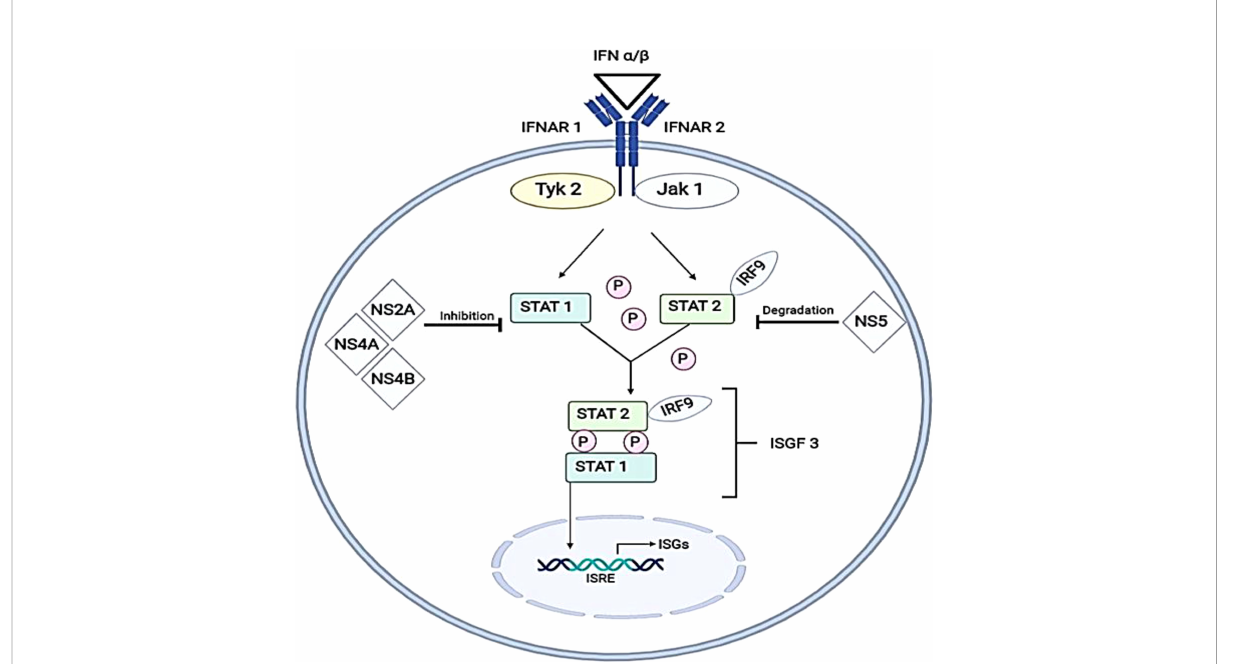
FIGURE 2 Inhibition of IFN a / b (type I IFN) signaling pathways by DENV virus. The pathway of formation for IFN-stimulated gene complex 3 (ISGF3) before translocating into the nucleus to induce IFN-stimulated genes by binding with IFN-stimulated response element (ISRE) is illustrated. DENV antagonizes this pathway by either inhibiting the active phosphorylation of STAT1 (by NS2A, NS4A and NS4B) or by direct degradation of STAT2 (by NS5). This illustrates mechanisms will occur in the absence of enhancing antibodies. IFNAR1, Interferon alpha and beta receptor subunit 1; IFNAR2, Interferon alpha and beta receptor subunit 2; Tyk2, Tyrosine kinase 2; JAK1, Janus kinase 1; IRF9, Interferon regulatory factor 9; NS2A, Non-structural 2A protein; NS4A, Non-structural 4A protein; NS4B, Non-structural 4B protein; NS5, Non-structural 5 protein; STAT1, Signal transducer and activator of transcription 1; STAT2, Signal transducer and activator of transcription 2; ISGs, Interferon-stimulated